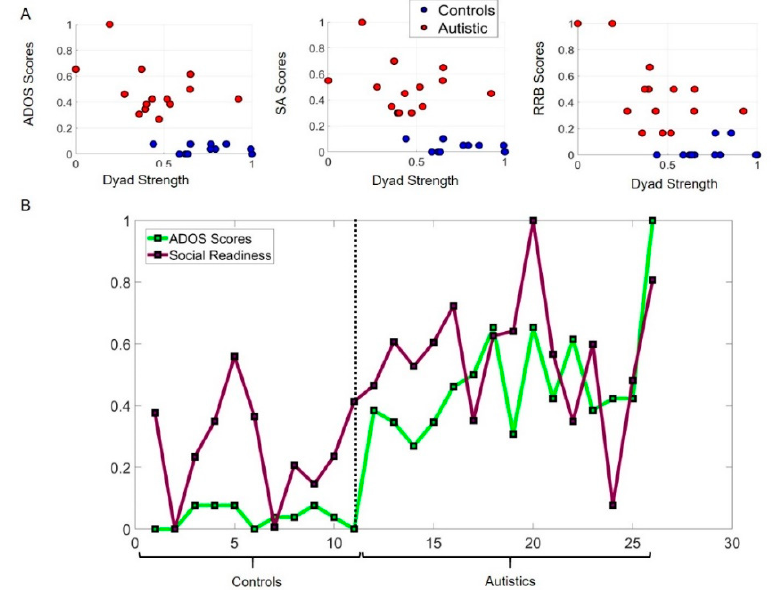
Figure 3. A measure of social readiness potential: Dyadic strength expressed in relation to ADOS sub-scores (Social A ff ect, (SA) and the so-called Repetitive Ritualistic Behaviors, (RRB)). ( A ) Dyad strength (see methods) tends to be higher in neurotypical controls, with a tendency towards lower (normalized) ADOS scores and some higher variations in the more ambiguous RRB sub-score. The trend in the autistic dyadic strength scores is towards lower values and higher ADOS score, yet 5 / 15, (33.3%) fall within the neurotypical lower range despite higher ADOS scores, thus signaling a hidden capacity for social dyadic exchange. ( B ) This information can be further unfolded for each participant, whereby a score of social readiness potential is obtained as a relative quantity measuring the absolute di ff erence between each participant and the neurotypical with the highest dyad strength. Many of the autistic participants do have socio-motor strength in the dyadic interaction, despite high ADOS scores.